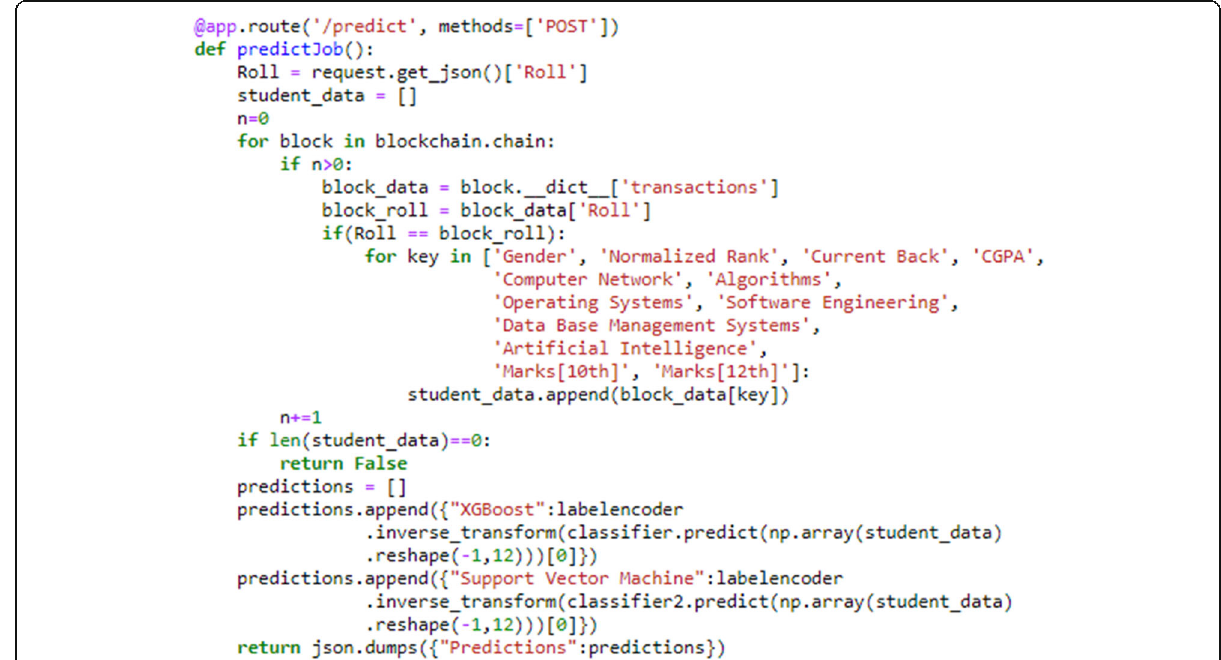
Fig. 10 Implementation of the ‘ /predict ’ router of the Flask server upon which the blockchain and ML model is running